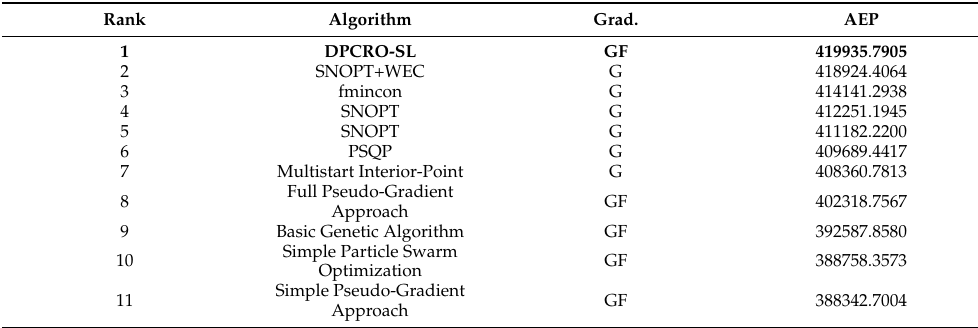
Table 4. Results for a wind farm boundary radius of 1300 m with 16 turbines, where our algorithm is highlighted.